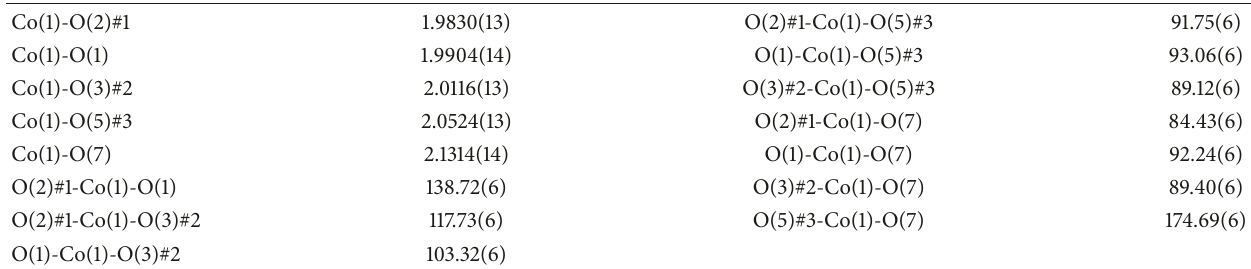
Table 2: Selected bond lengths [˚A] and bond angles [deg] of [BMI] 2 [Co 2 (BTC) 2 (H 2 O) 2 ].